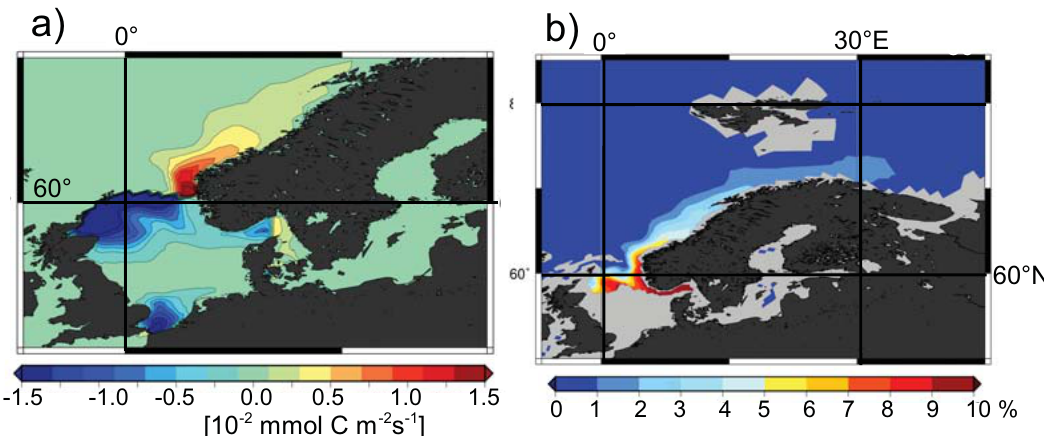
Fig. 9. (a) Sea–air carbon flux in experiment CO 2 -NS. A 10yr average of 1990–1999 is shown. Positive flux indicates degassing. (b) Relative change of dissolved inorganic carbon at 95m depth between experiments CO 2 -NS minus experiment CWE. Positive values indicate higher concentrations in experiment CO 2 -NS. An average over the years 1995–1999 is shown.